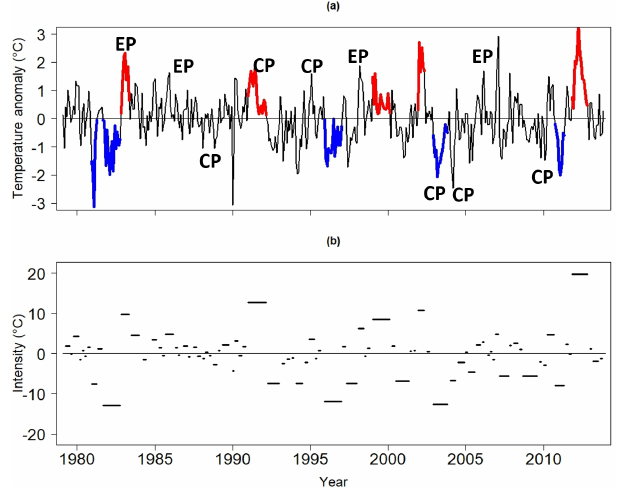
Figure 2. (a) The LIS surface temperature anomaly time series and (b) the corresponding event spectrum. Central Pacific El Niño events are indicated by CP and eastern Pacific El Niño events are in- dicated by EP. Blue curves represent the five most intense negative LIS temperature events, while red curves represent the five most intense positive LIS temperature events. The length of the line segments in (b) represents the persistence of the LIS temperature events. The vertical axis corresponds to the intensity of the event.